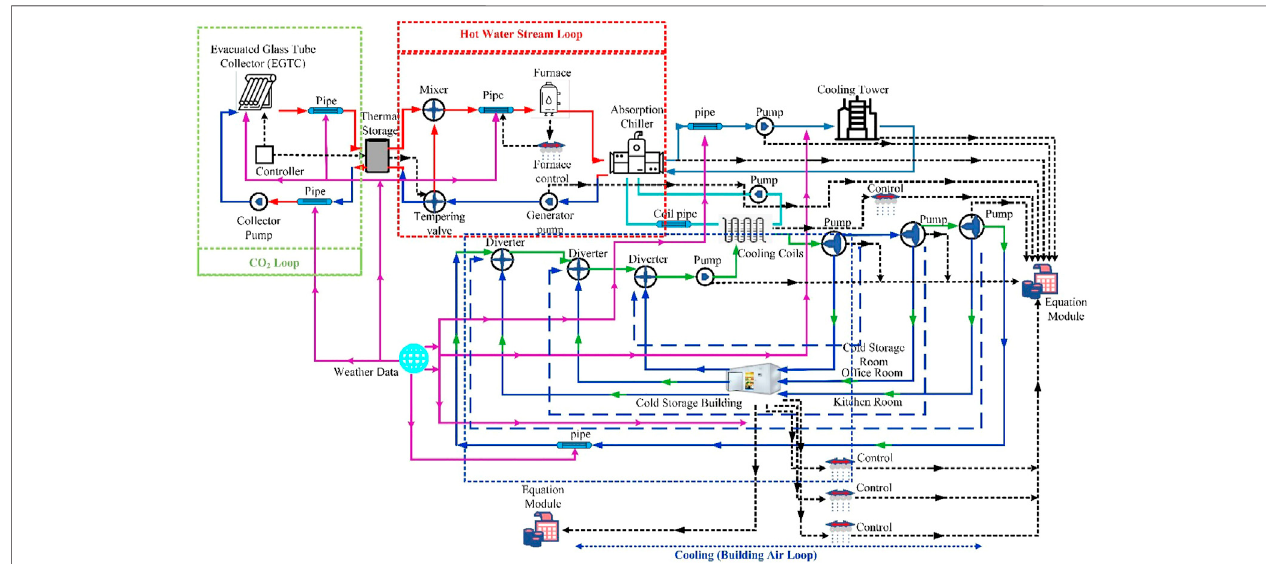
FIGURE 5 | Solar thermal air conditioning system using CO 2 as a mediating fl